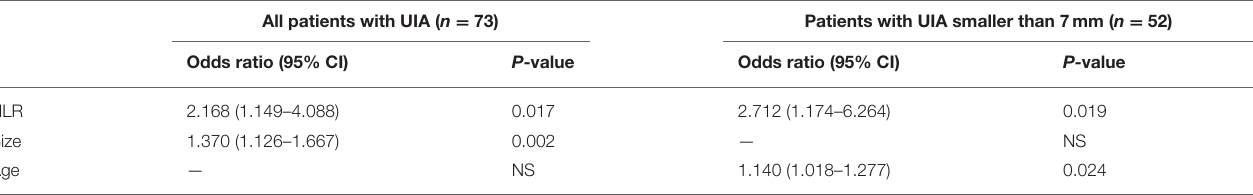
TABLE 3 | Multiple logistic regression analysis for circumferential aneurysm wall enhancement in the unruptured intracranial aneurysm. All patients with UIA ( n =